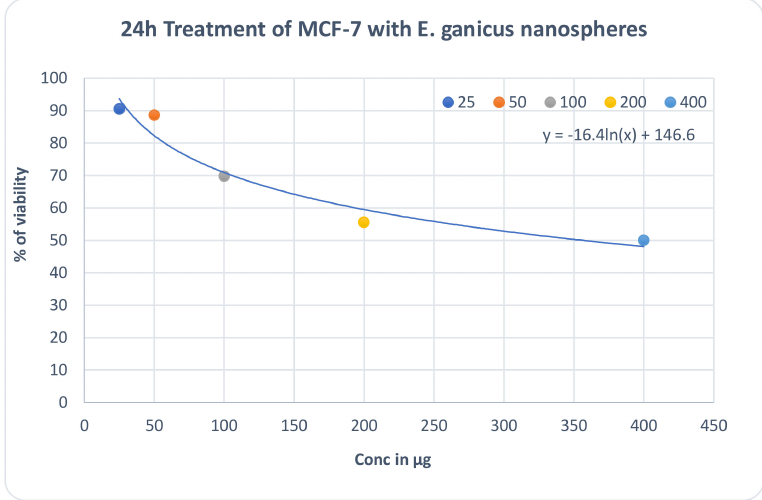
Figure 13. Graphical representation of the MTT assay-cell viability test results.